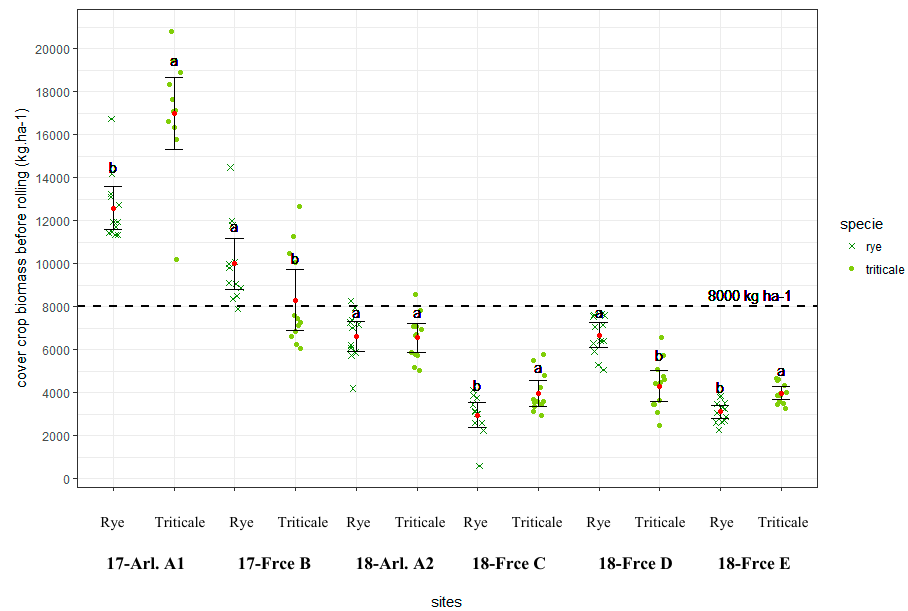
Figure 3. Cover crop biomass before termination per species and per site, 2017 and 2018. The letters represent the results of the ANOVAs per site ( p < 0.05, n = 24). For each site, if the two species have the same letter their biomass is not significantly di ff erent. The dotted line refers to a mean of the cover crop biomass values range reported in the scientific literature as a success factor to suppress weed until soybean